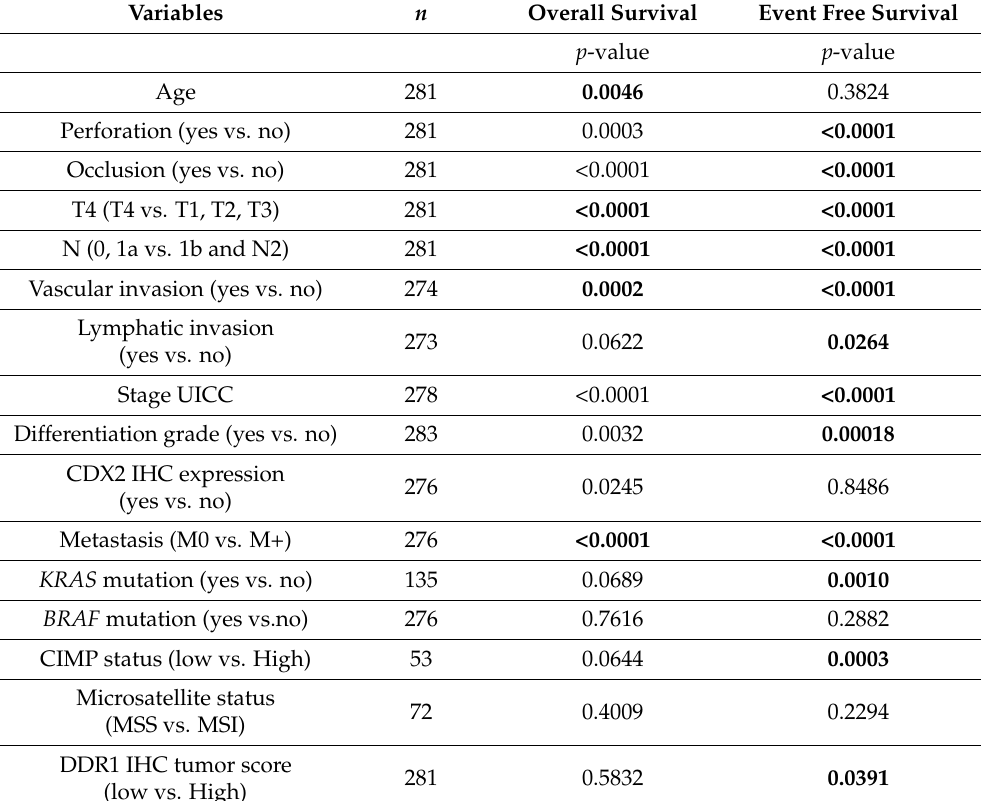
Table 3. Analysis of factors associated with overall and event-free